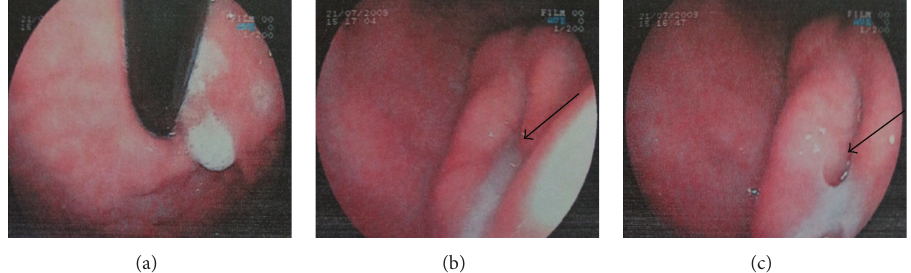
Figure 2: Upper GIS endoscopy. A mass in the antrum and a fistula orifice with purulent flux were determined (marked with an arrow).